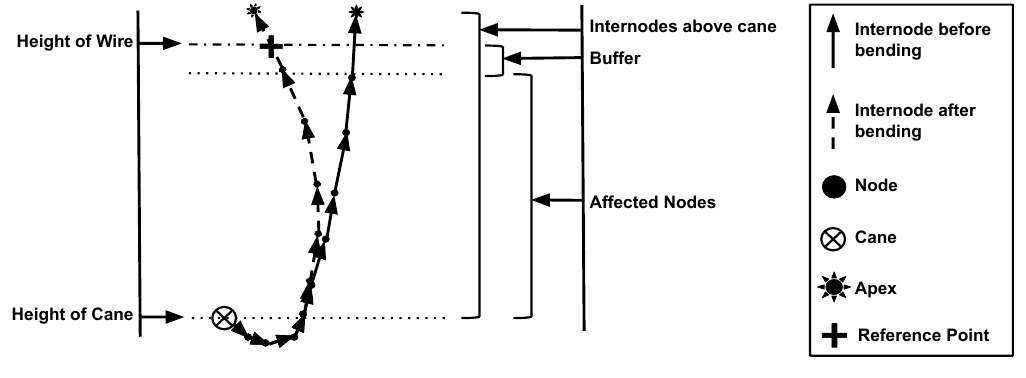
Figure 9. Schematic representation of reorientation of a shoot due to shoot positioning by tucking with a wire: shoot before bending ( right ); and shoot after bending ( left